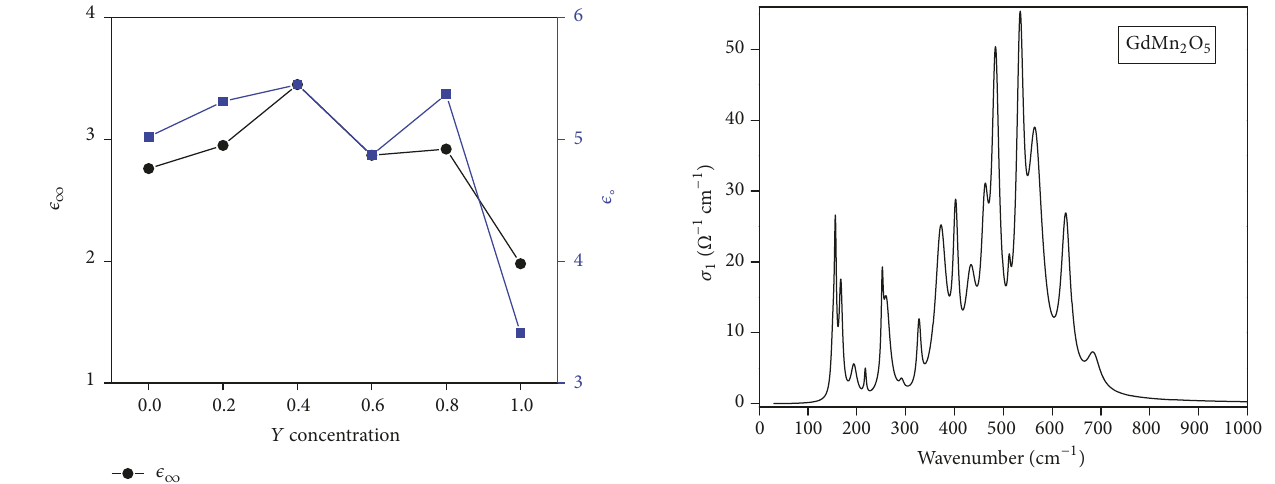
Figure 7: Real part of optical conductivity ( 𝜎 1 (𝜔) ) for GdMn 2 O 5